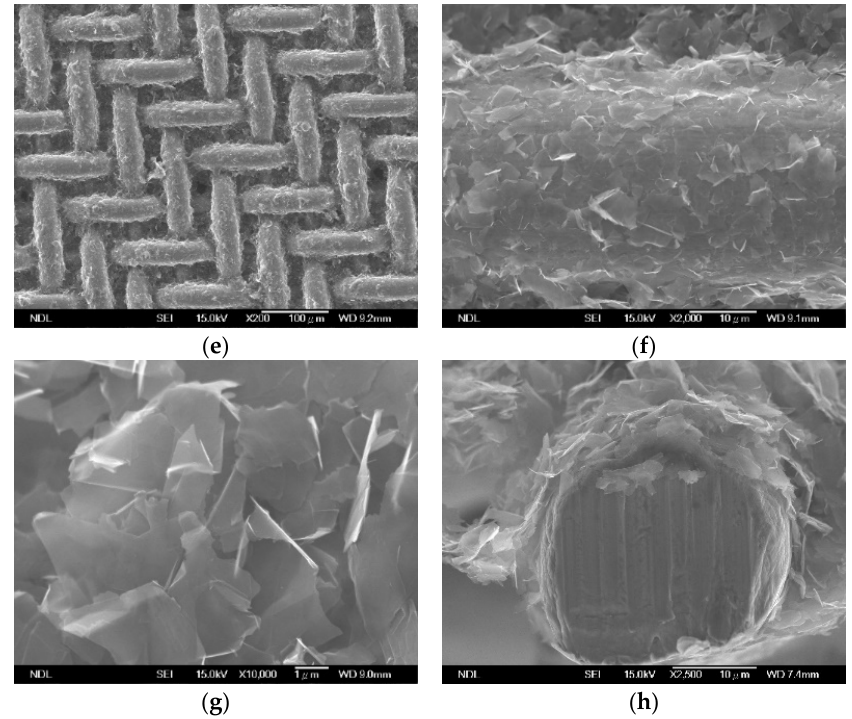
Figure 2. Surface of stainless steel mesh electrodes after one layer ( a – d ) and four layers ( e – h ) of spin coating with graphene suspension (GS).